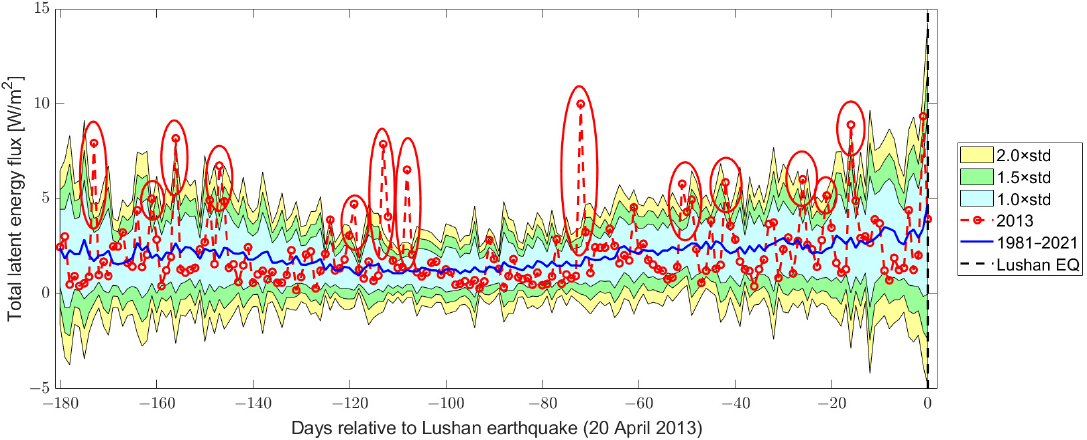
Figure 16. Total latent energy flux from the six months before the Mw 6.7 Lushan 2013 earthquake.